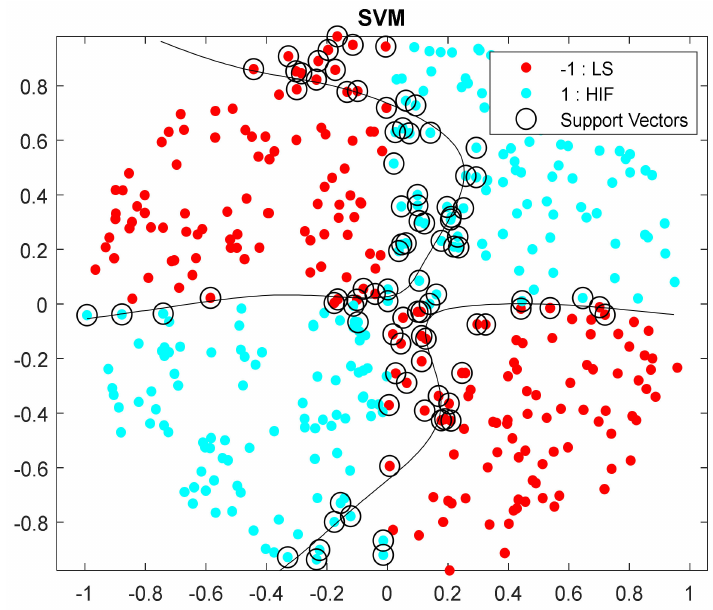
Figure 6. SVM classification between HIF and